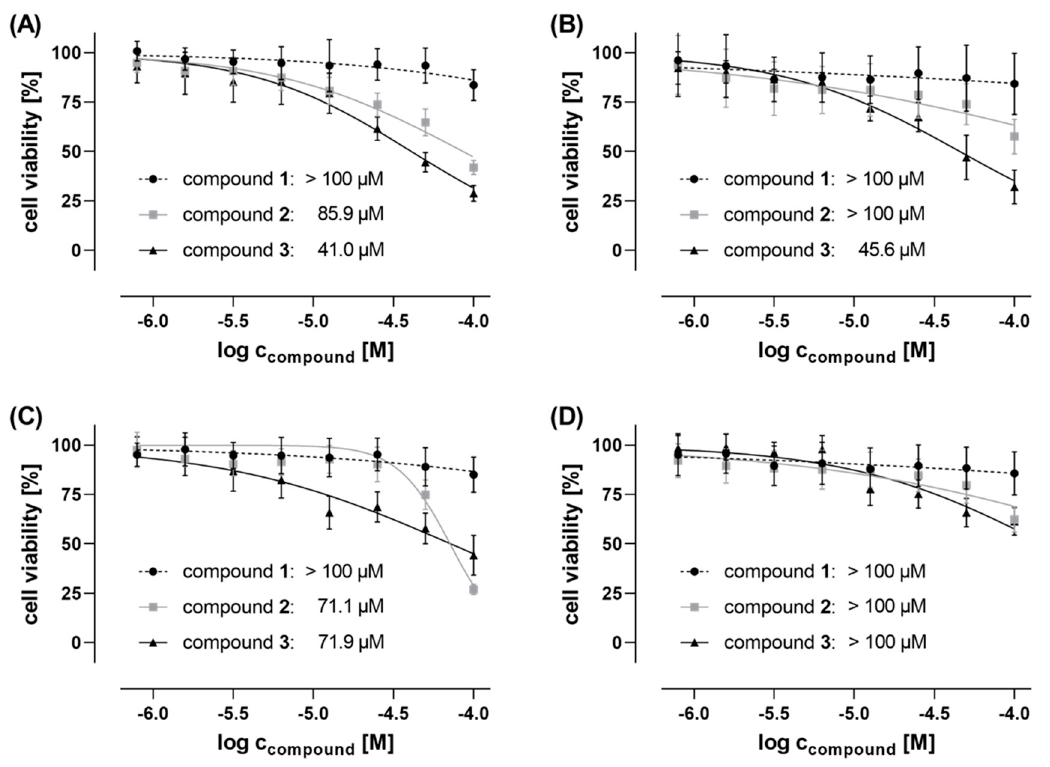
Figure 5. Cell viability of ( A ) breast cancer MDA-MB-468 cells, ( B ) breast cancer MDA-MB-231 cells, ( C ) Ewing’s sarcoma SK-N-MC cells, and ( D ) prostate cancer PC-3 cells treated for 48 h with compounds 1 ( ● ), 2 ( ■ ), and 3 ( ▲ ), respectively, as determined by MTT assay. Data has been normalized to cell viabilities between 0% (represented by digitonin-treated cells; cytotoxic positive control) and 100% (represented by untreated cells; negative control). IC 50 values of the anti-proliferative/cytotoxic compound activities have been calculated by using GraphPad Prism 8.0.2 software and are given in micromole concentrations. Data has been collected in two independent biological replicates each with technical quadruplicates.